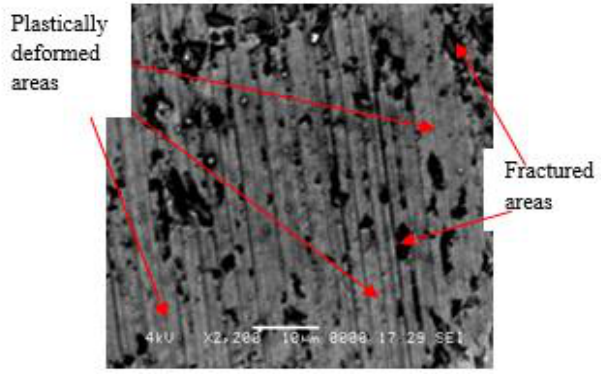
Figure 12: Scanning Electron Microscopic image for trial run 16 in Table 2: grit size = 76 µm, depth of cut = 30 µm an 22 mm/min showing large areas of plastically deformed